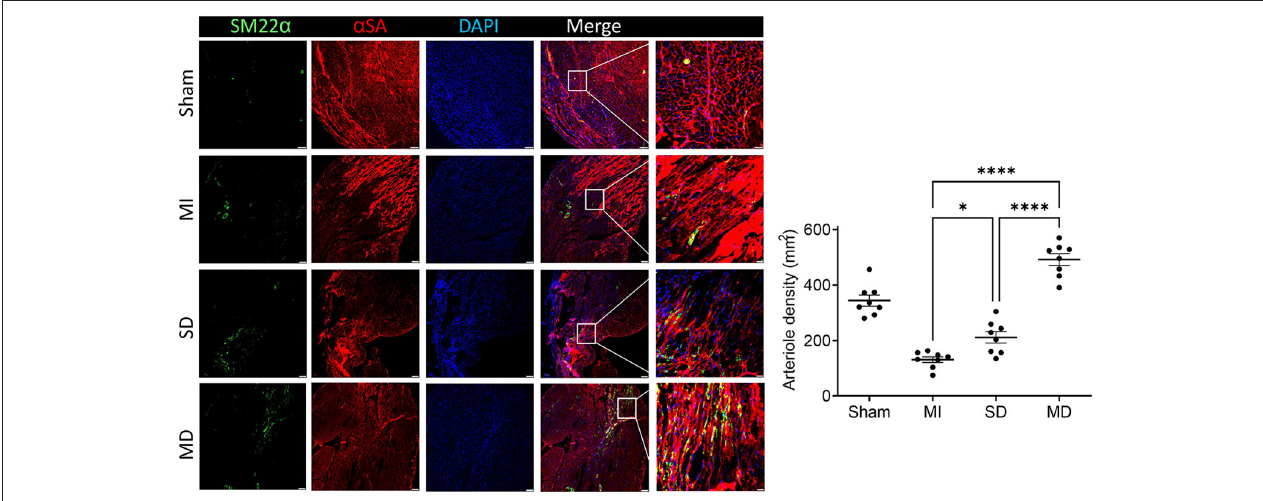
FIGURE 6 | Assessment of arteriole density. Histochemical staining was performed on serial frozen sections of sham-operated, MI, SD, and MD-treated mouse hearts that were sacrificed 4 weeks after MI induction to confirm the presence of arterial structures. The number of artery is quantified as the number of SM22 α -positive arterial structure in the area around the infarct per square millimeter. Data are means ± SE. Eight animals per group. Scale bar = 20 and 10 µ m for the unenlarged and enlarged panels, respectively. One-way ANOVA with Dunn’s multiple comparisons test. * p < 0.05; **** p <